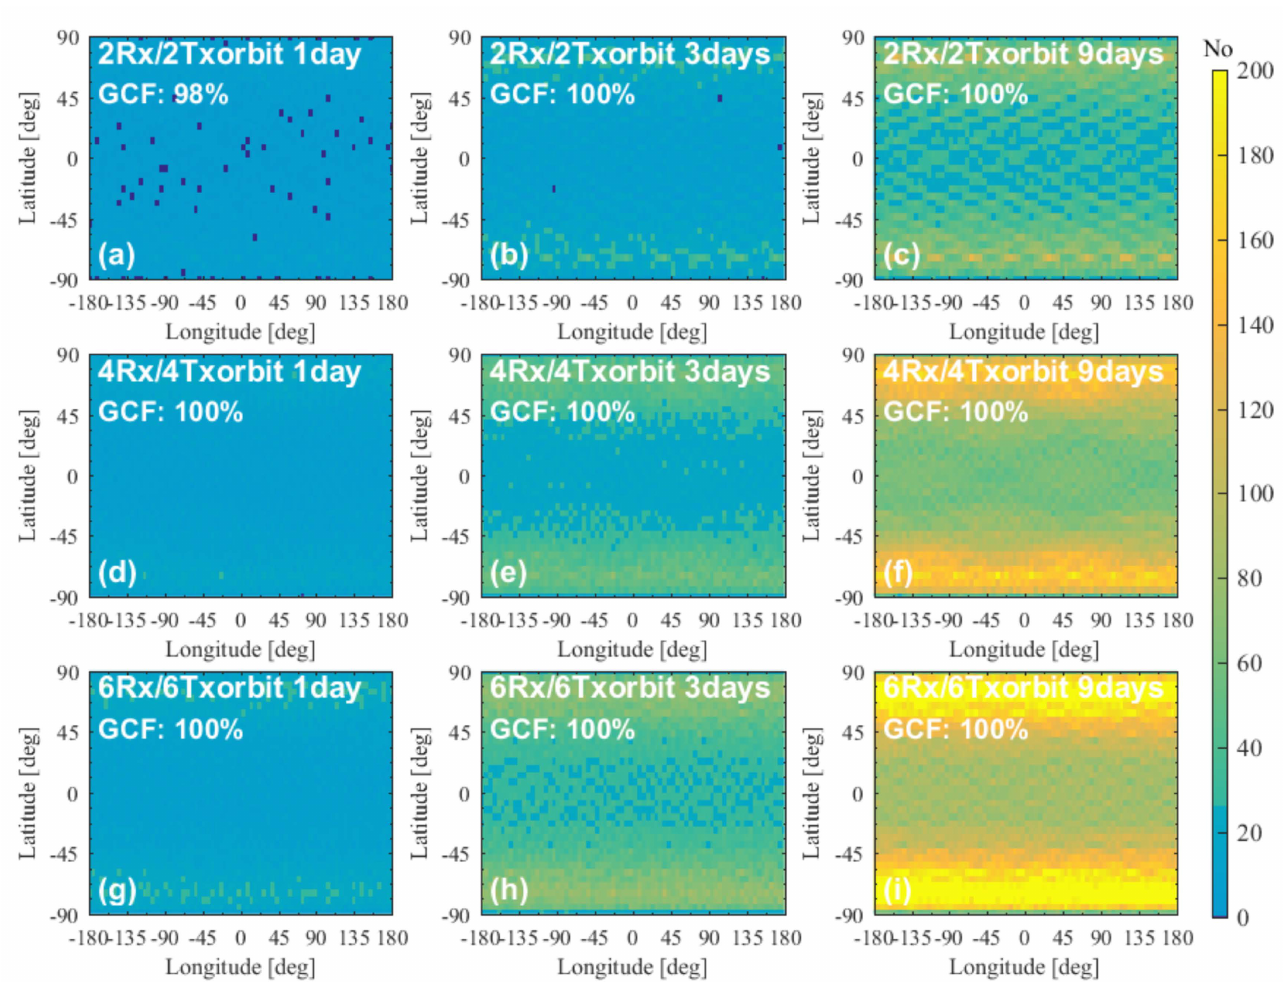
Figure 15. The global coverage of LEO-LEO occultation events for the 2Rx/2Txorbit, 4Rx/4Txorbit, and 6Rx/6Txorbit constellations with the Rxi98 and Txi98 inclination orbital planes, illustrating the occultation numbers per 5 ◦ × 5 ◦ latitude and longitude grid cell. The GCFs were calculated using grid cell areas according to Equation